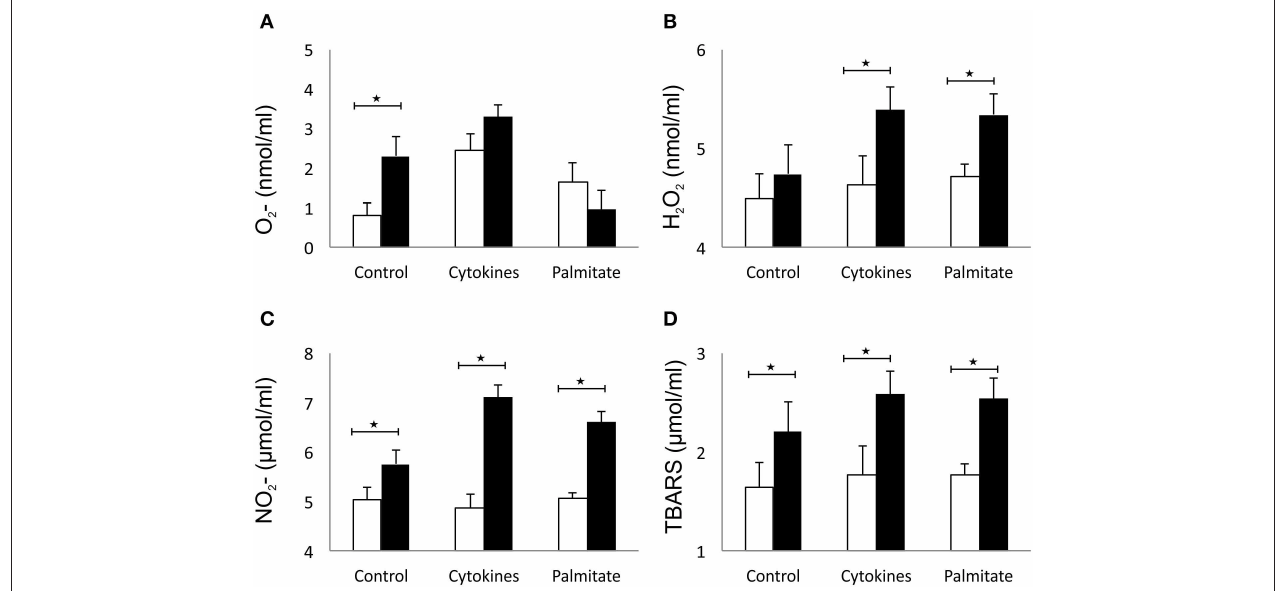
FIGURE 5 | Galectin 3 overexpression increases the oxidative stress of β cells in vitro. Overexpression of galectin 3 led to an inherent capacity of islet cells to produce oxygen free radical O 2 − in the control group, while there were no differences after stimulation with an IFN- γ , IL-1 β , TNF- α cocktail (A) . Overexpression of galectin 3 exerted a prooxidant effect and increased levels of H 2 O 2 after 24-h stimulation with proinflammatory cytokine cocktail (B) . Galectin 3 overexpression plays a prooxidant role independently of cytokine stimuli, as evaluated by levels of NO and thiobarbituric acid reactive substances (TBARS) (C,D) . Data from two experiments with 5–8 mice per group are shown as mean ± SEM; by Mann-Whitney U -test and independent-sample Student’s t -test; * p <